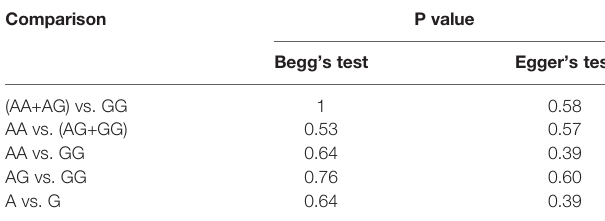
TABLE 4 | Publication bias analysis of included studies.